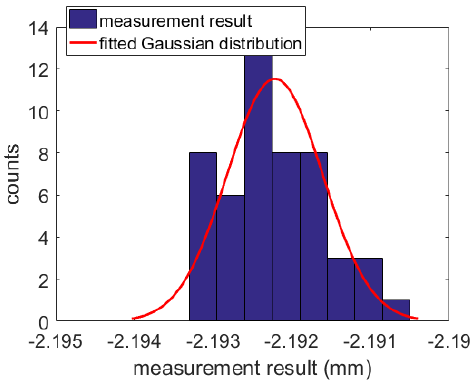
Figure 17. Evaluation result for the measurement uncertainty for the trigger probe using the repeated measurement method.